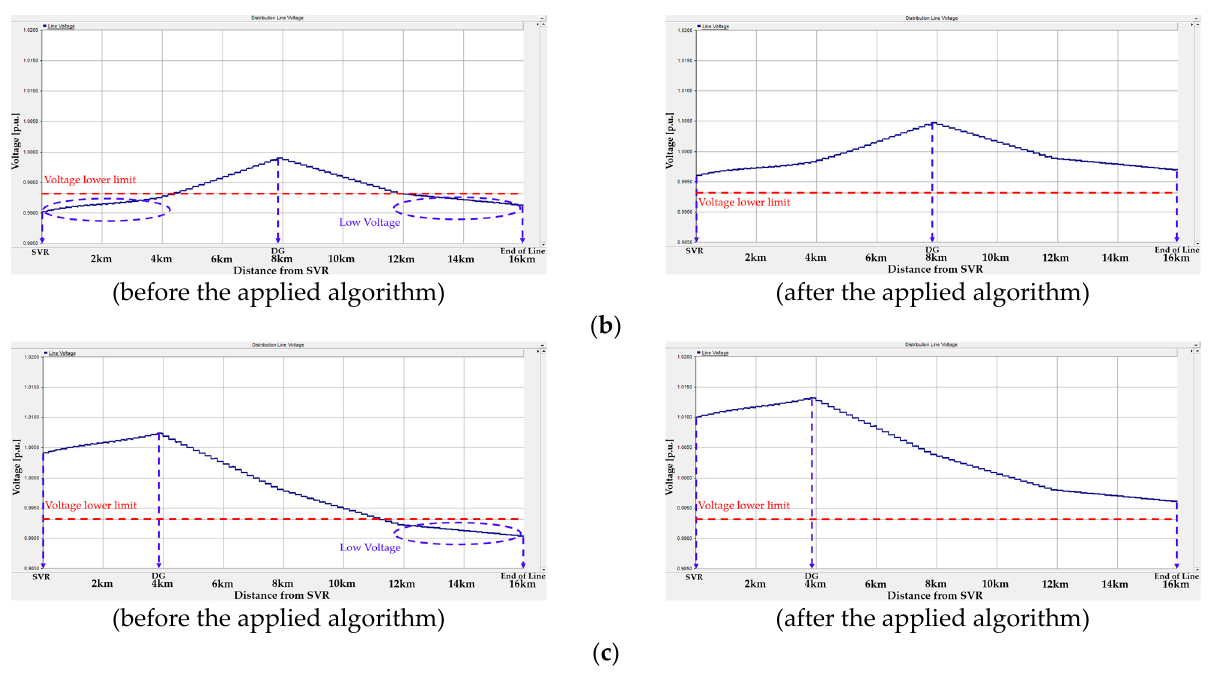
Figure 13. Distribution line voltage profiles by conventional and proposed voltage control in Type 2: